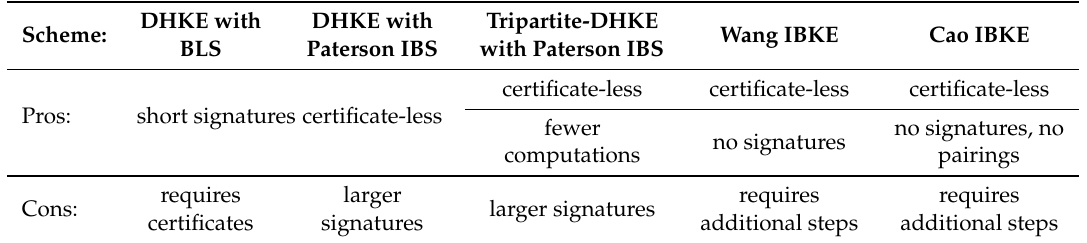
Table 1. Overview of advantages and disadvantages for the schemes discussed in this